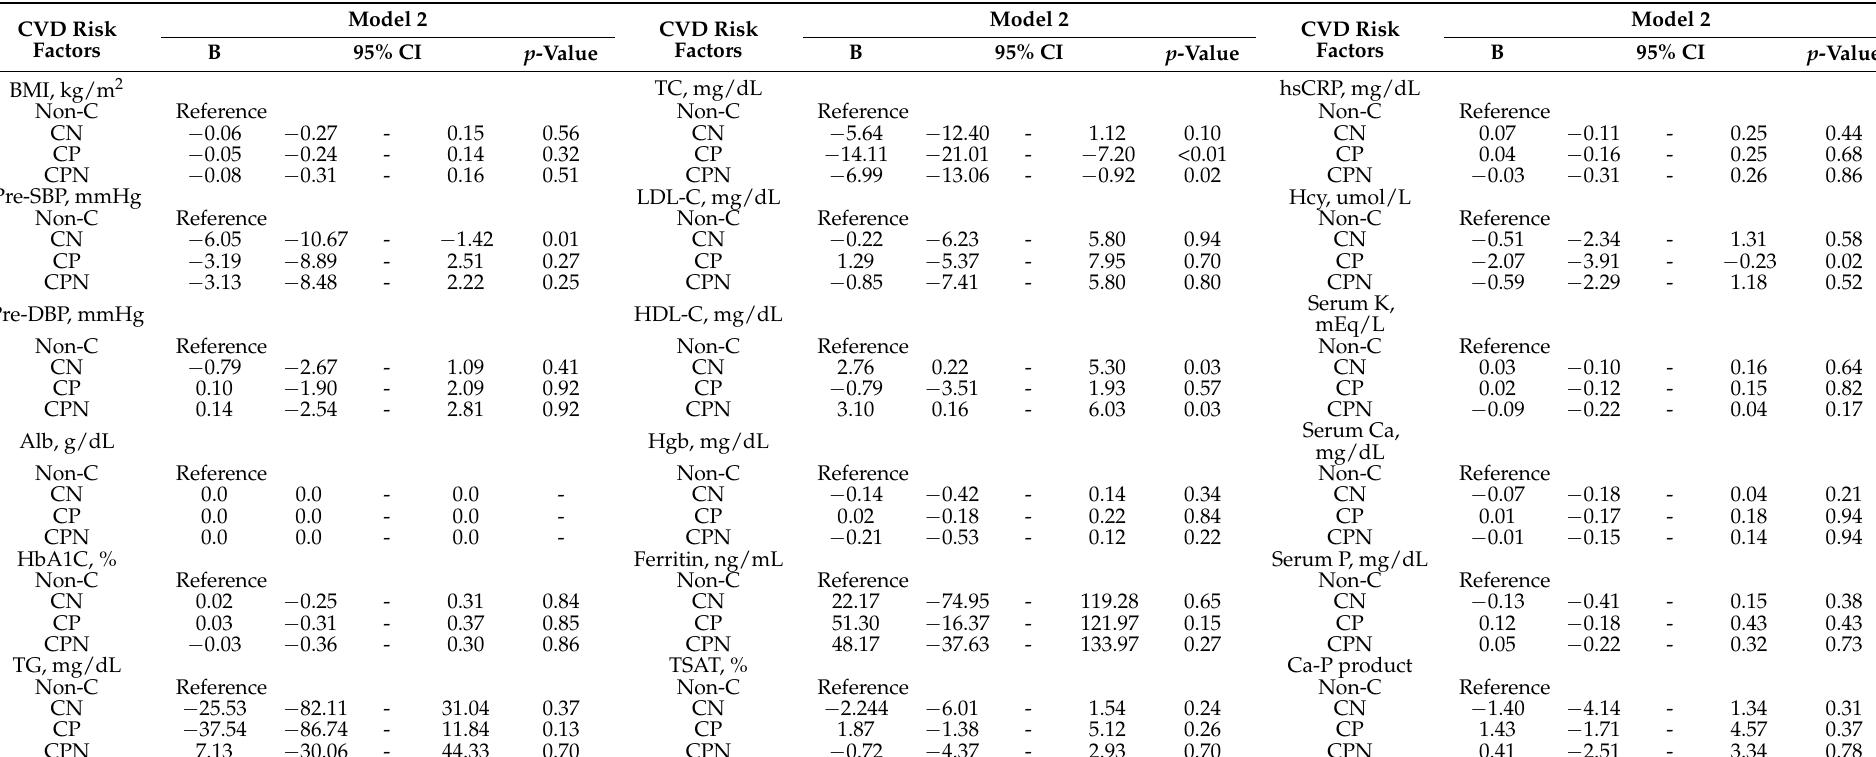
Table 5. Comparison of the changes in CVD risk factors in different education models during the experiment, with non-C as the reference group